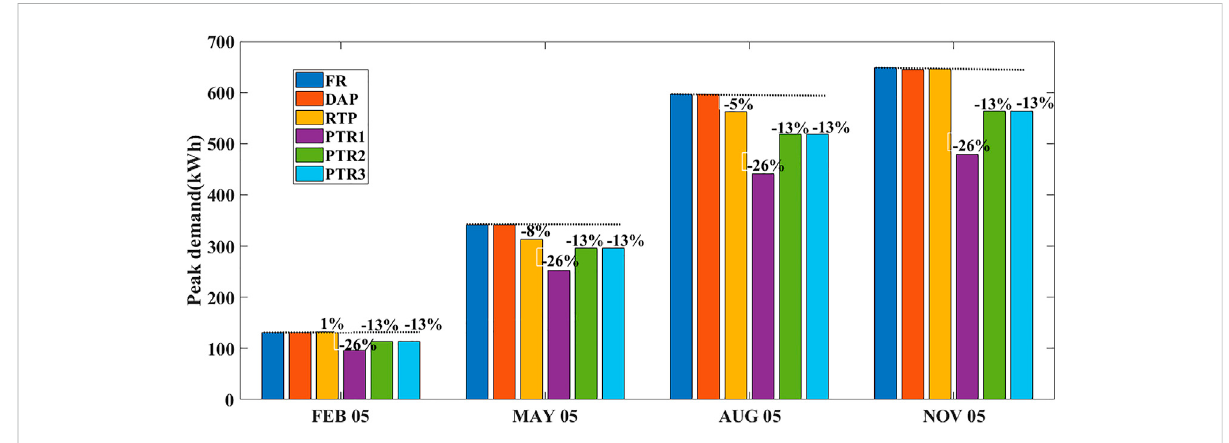
FIGURE 12 Percentage change in peak demand for all seasons and all pricing schemes.